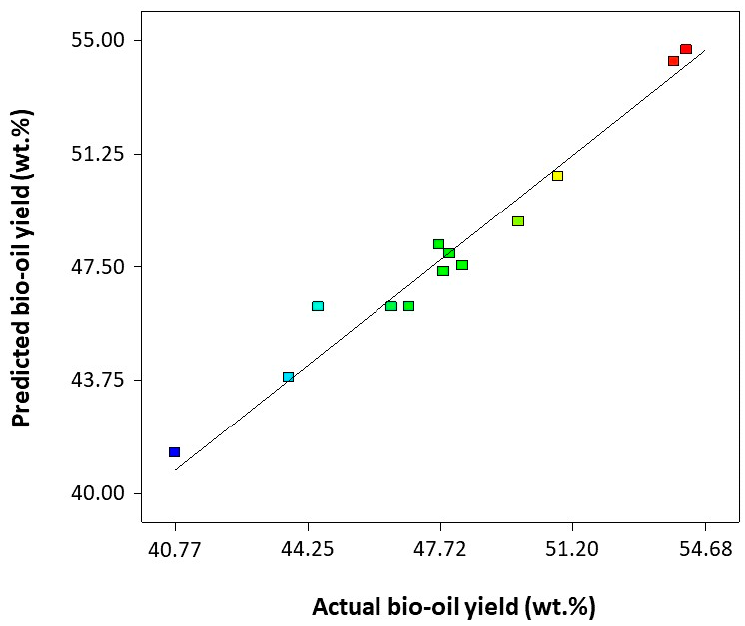
Figure 3. Parity plot showing the predicted and experimental bio-oil yields from pigeon pea wood pyrolysis.